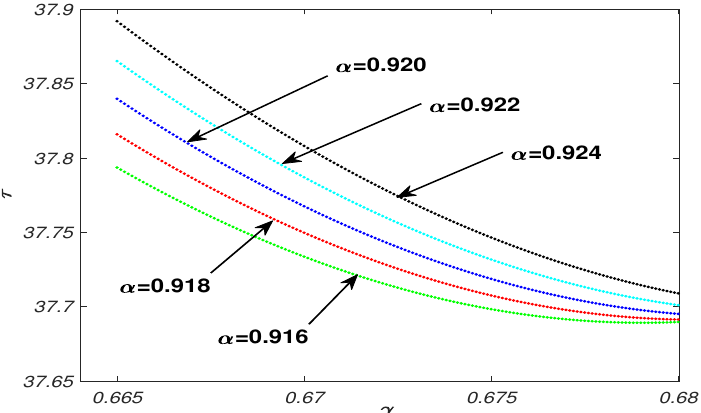
Figure 11. The influence of continuous antibody failure rate γ and discrete secondary vaccination ( 0 ) rate α on the critical time τ 1